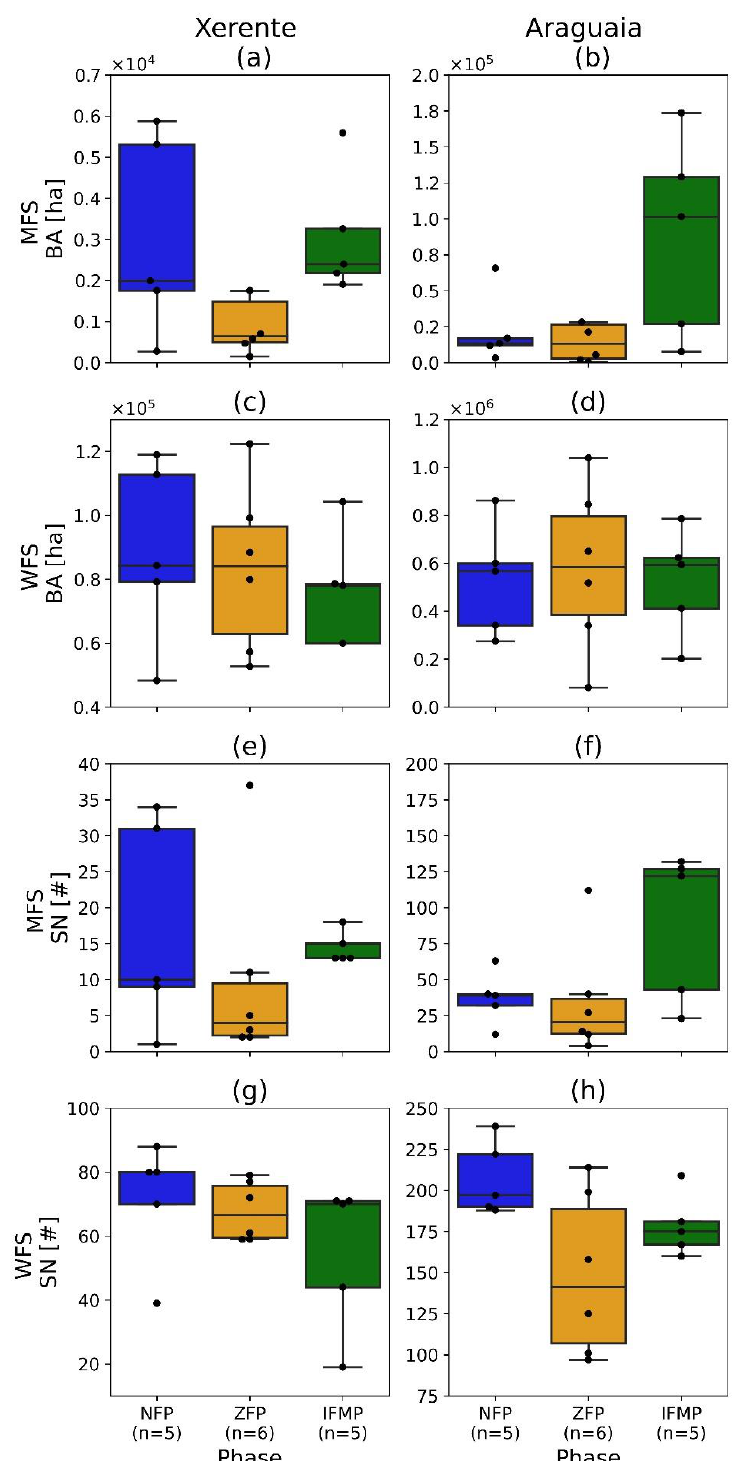
Figure 3. Boxplot for annual accumulated burned area (BA, a – d ) and total scar number (SN, e – h ) in MFS ( a , b , e , f ) and WFS ( c , d , g , h ) in the Xerente ( left column ) and Araguaia ( right column ) for each phase. Annual values are depicted in black dots.